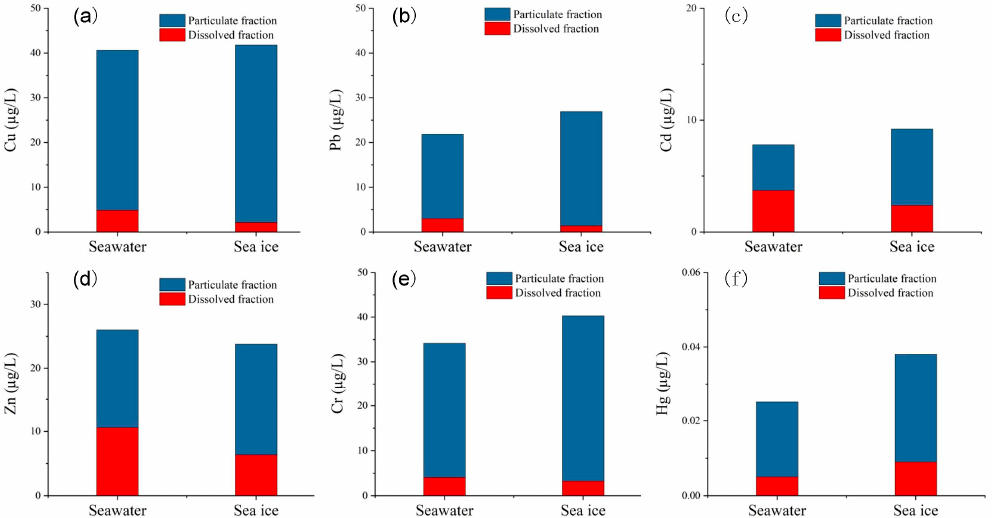
Figure 3. The average concentrations of particulate and dissolved heavy metals in seawater and sea ice over 30 coastal sites in Liaodong Bay. ( a ) Cu; ( b ) Pb; ( c ) Cd; ( d ) Zn; ( e ) Cr; ( f )